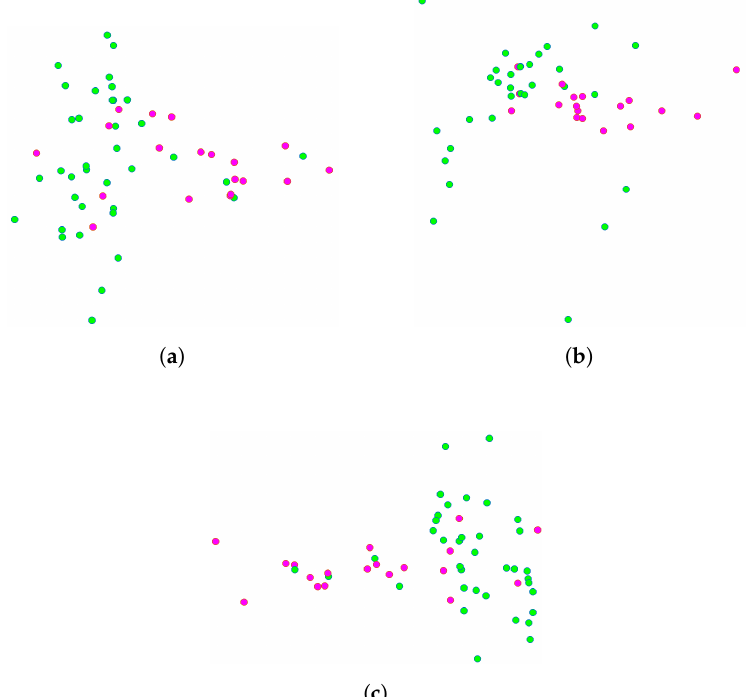
Figure 6. Three dimensional projection by linear discriminant analysis (LDA) for 0-dimension ( a ), 1-dimension ( b ) and 0- and 1-dimensions ( c ). Green points represent bots and pink points represent